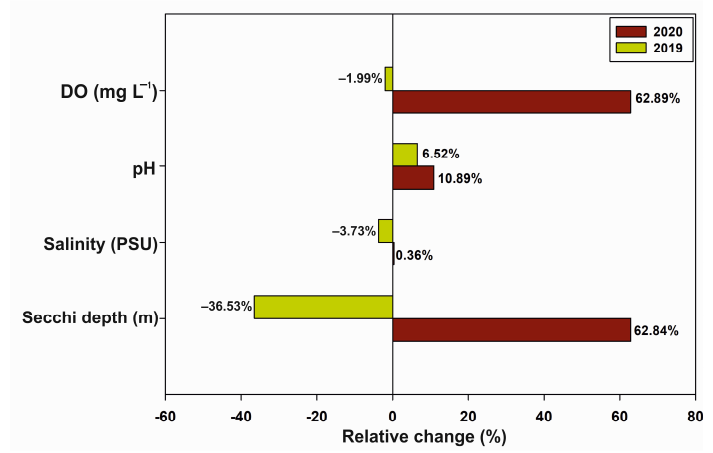
Figure 5. Percentage change in the variation of the water quality parameters in 2019 (pre-demolition) and 2020 (post